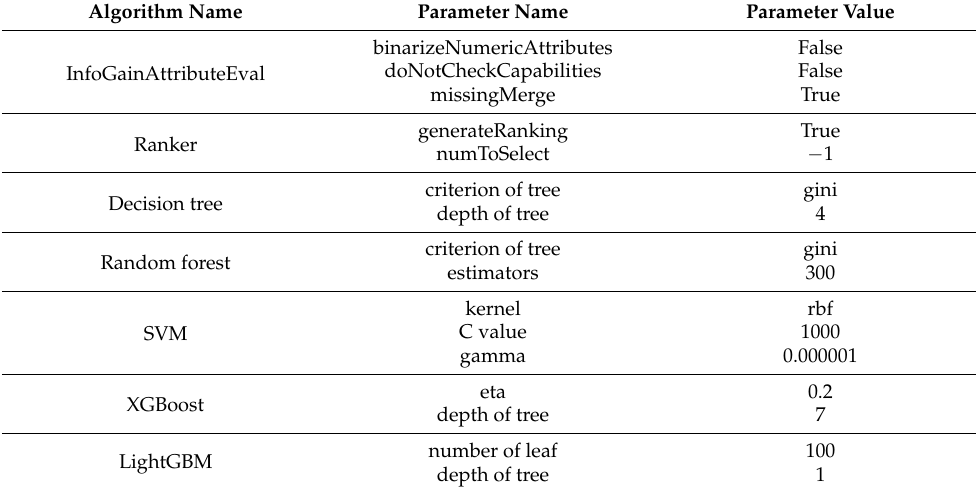
Table 2. The parameters of machine learning and feature selection.